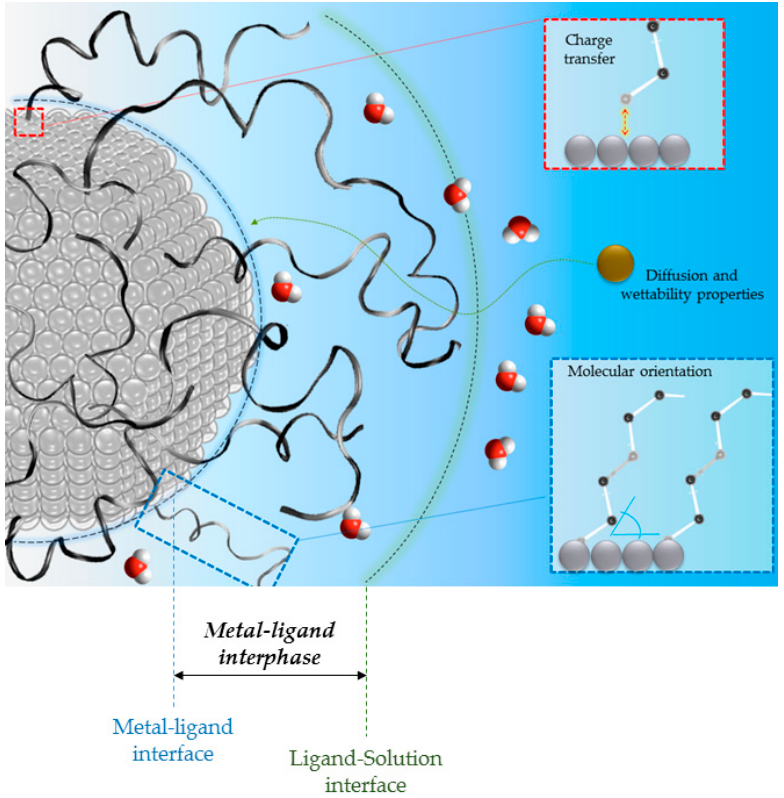
Figure 2. The metal ‐ ligand interphase. Figure 2. The metal-ligand